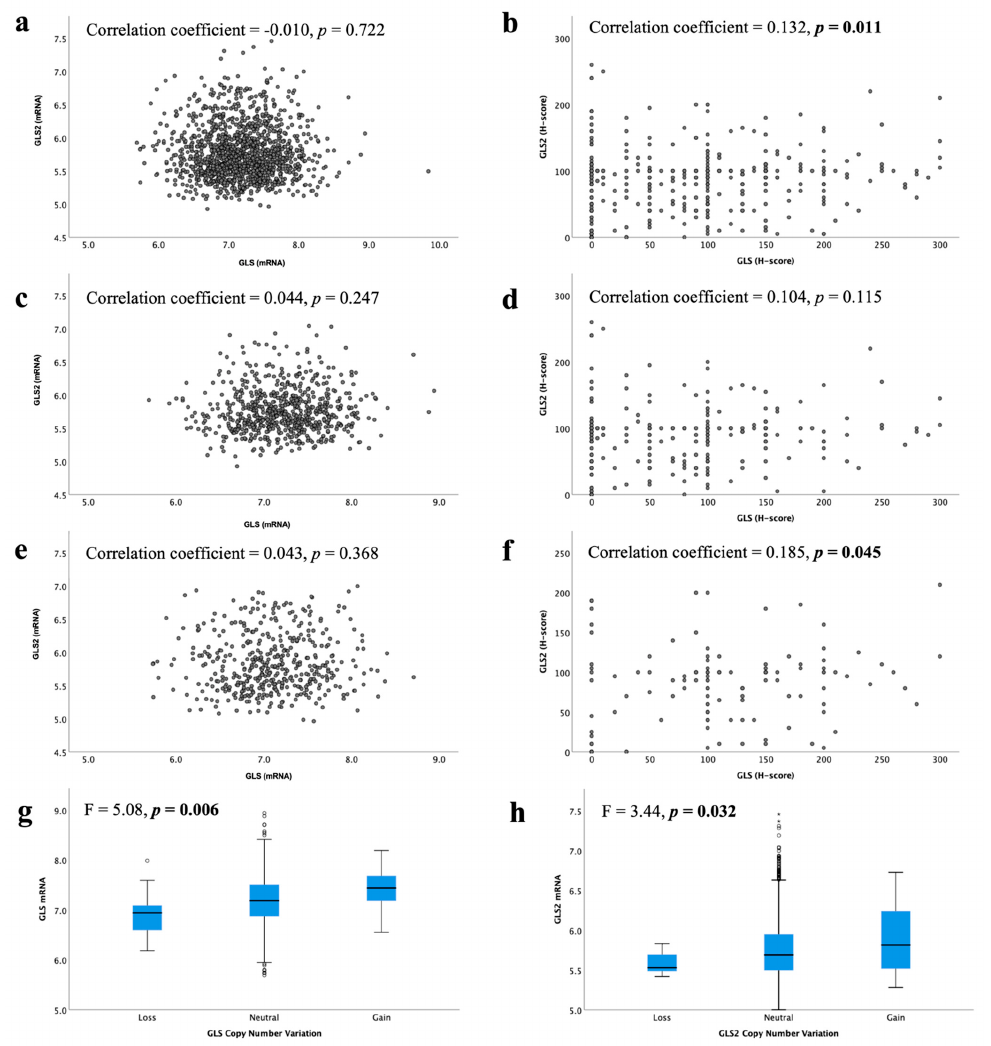
Figure 3. Correlation between glutaminase mRNA and protein expression in ER +/HER2- invasive breast cancer: GLS and GLS2 mRNA in ( a ) all tumours, ( c ) luminal A tumours, ( e ) luminal B tumours; GLS and GLS2 protein in ( b ) all tumours, ( d ) low proliferation tumours, ( f ) high proliferation tumours. Copy number gain and relationship with mRNA expression for ( g ) GLS and ( h ) GLS2 were analysed using Pearson’s correlation coefficient. Data represented with median ± standard deviation. Statistically significant p values are in bold .